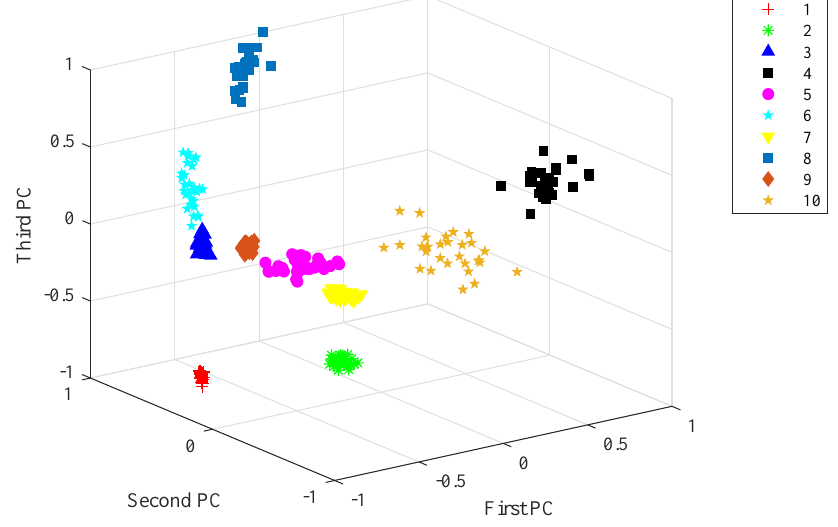
Figure 7. Features extracted from 1D-SCNN.